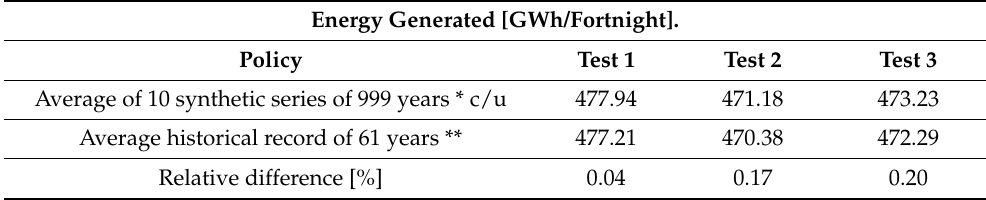
Table 8. Long-term total energy comparison: 10 synthetic series vs. historical record. Energy Generated